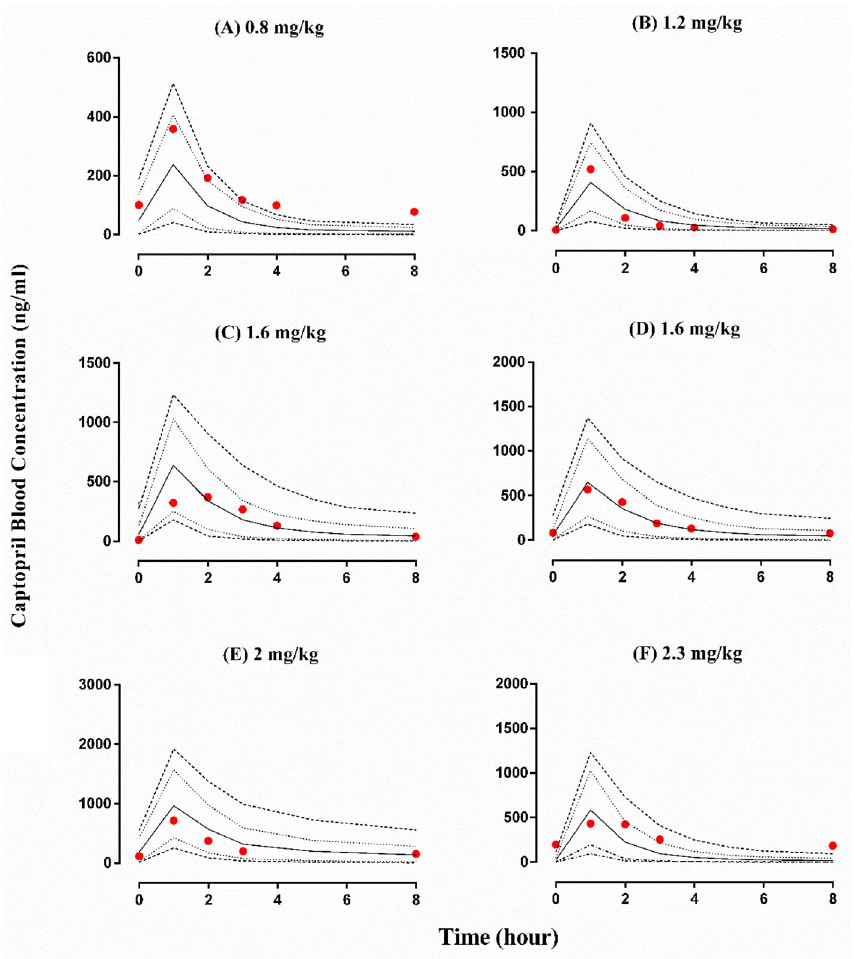
Figure 2. Captopril blood concentration vs time profiles in 6 pediatric patients with renal failure 40 .- (---) maximum predicted concentration, - (-·-) minimum predicted concentration, - (- -)5th percentile, - (· ··) 95th percentile, - (—) mean predicted concentration, - (•) observed